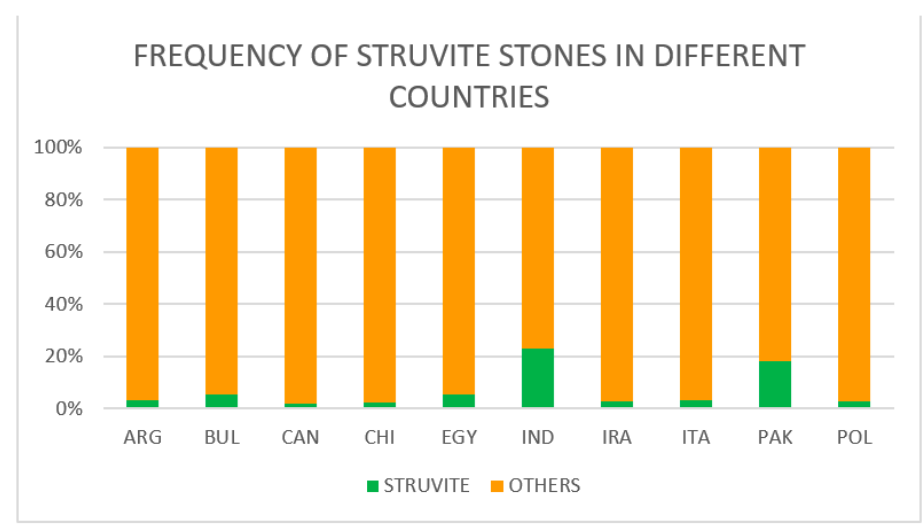
Figure 2. Rates of struvite stones in stone formers from different countries.